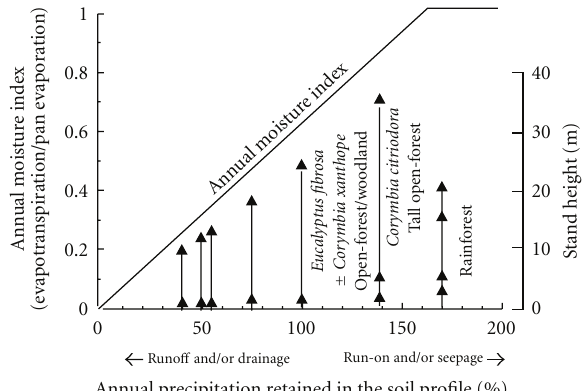
Figure 4: Vegetation on a soil catena on a serpentinite substrate in State Forest no. 114, Rockhampton-Marlborough region, Central Queensland (23 ◦ 06 (cid:3) S, 149 ◦ 58 (cid:3) E) ([113], see [5, Figure 12.18]).